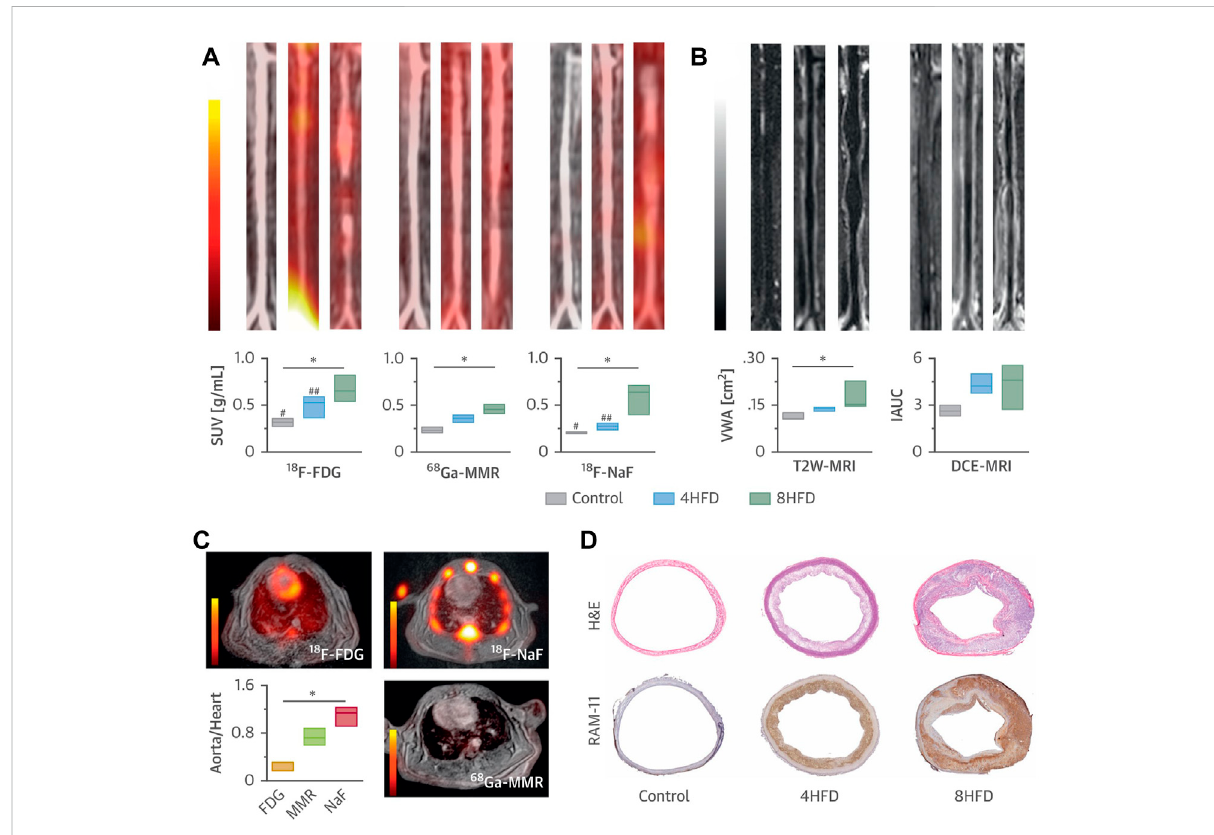
FIGURE 6 (A) Representative coronal aortic fused PET/MR images for 18 F-FDG (3 h) (left), 68 Ga-MMR (2 h) (middle) and 18 F-NaF (1.5 h) (right), and (B) representative T 2 W-MRI (left) and DCE-MRI (right) images from healthy and atherosclerotic rabbits (on high-fat diet for 4 months or 8 months, n ≥ 3 per group). (C) Cardiac PET/MR images of the respective tracers and associated aorta-to-heart ratios in rabbits with atherosclerosis (8 HFD). (D) Aortic sections taken from healthy control subjects and atherosclerotic rabbits (4 HFD or 8 HFD) and stained with H&E and RAM-11 (macrophages). * p < 0.05; 18 F -FDG versus 18 F -NaF: # p < 0.05; ## p < 0.01 (Copyright permission from Elsevier) (Senders et al.,